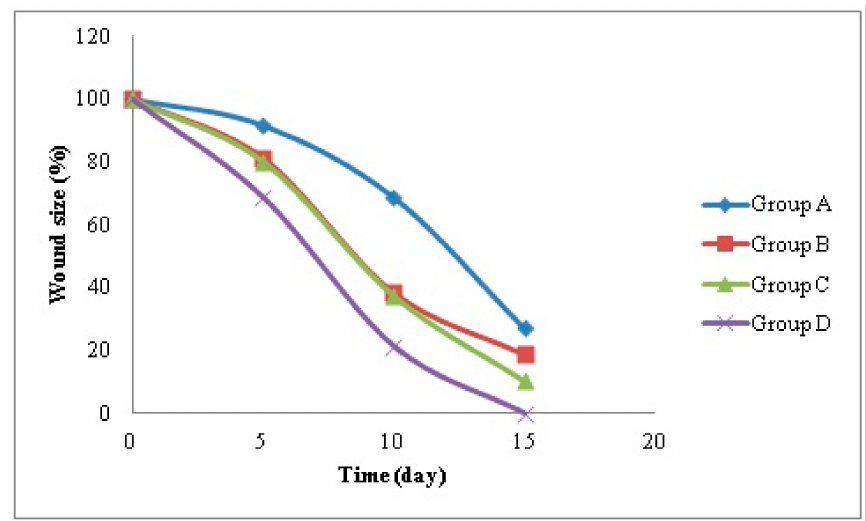
Figure 9. Changes of wound sizes throughout the 15 days of wound healing in non-treated control group ( A ), treated group with NVH suspension ( B ), treated group with blank chitosomal formulation ( C ) and treated group with NVH-loaded chitosomal formulation F6 ( D